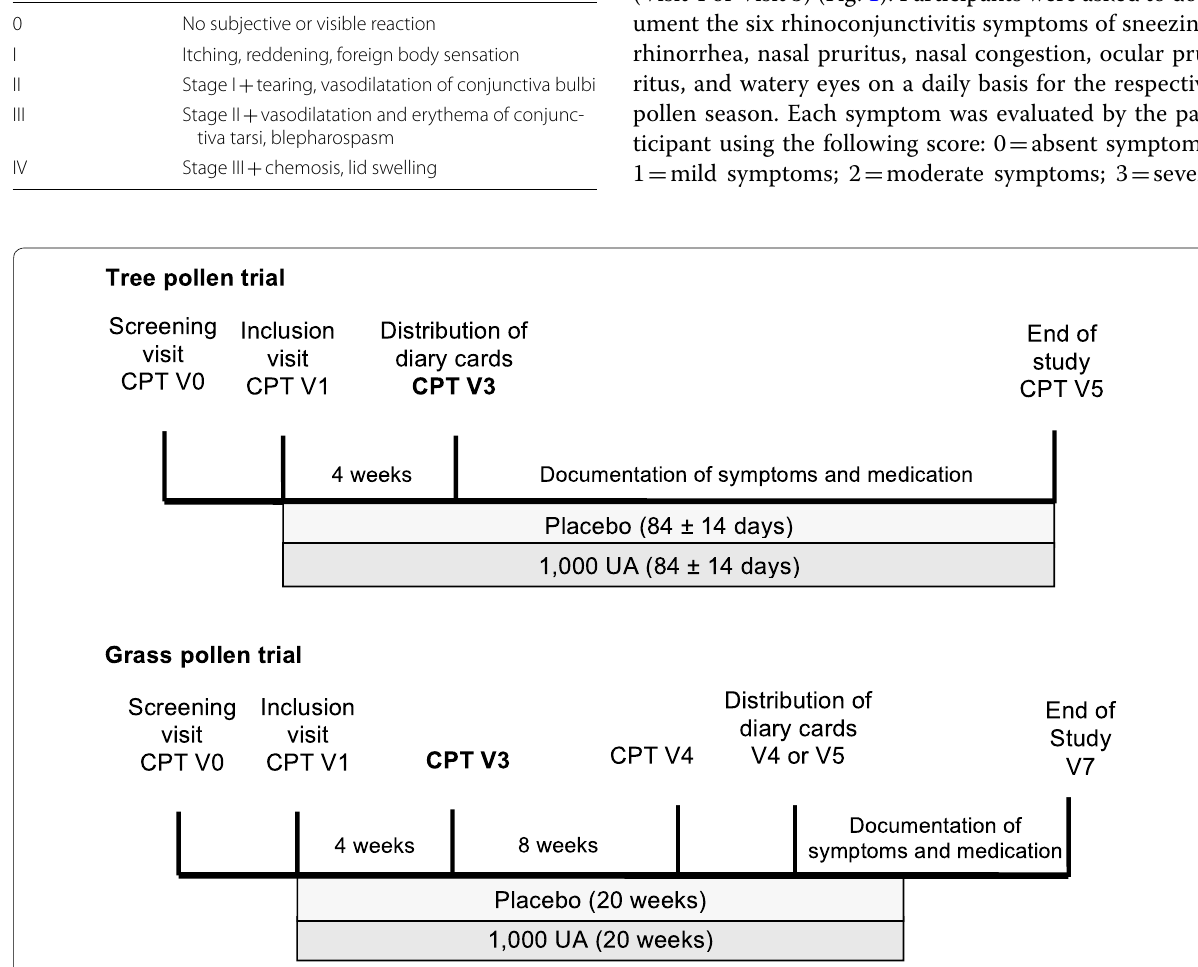
Fig. 1 Study design. Timelines of study visits and procedures carried out in the two trials. CPT conjunctival provocation test, UA unit of allergen, V